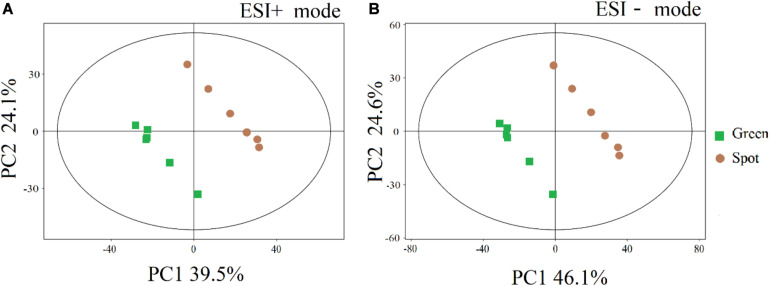
PCA scores of different parts of the leaves. (A) Electrospray ionization positive mode. (B) Electrospray ionization negative mode. The abscissa PC1 and ordinate PC2 represent the scores of the first and second principal components, respectively, and the color and shape of points represent the experimental groups of samples. All samples are within the 95% confidence intervals.